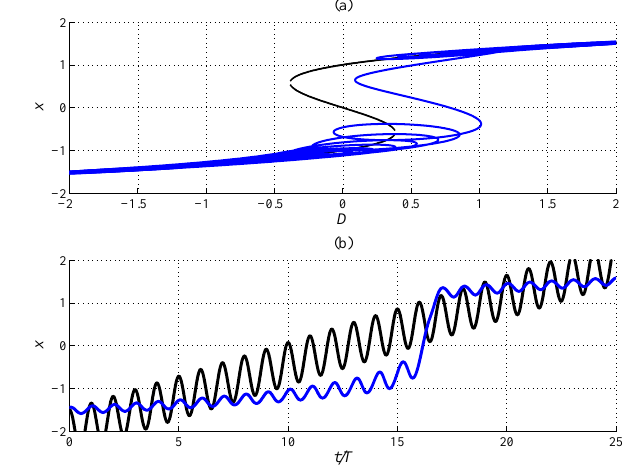
Figure 3. The early warning indicators, response amplification (up- φ lag = per panel), A = D a τ √ , and phase lag (middle panel), 2 π 1 + ω 2 τ 2 1 arctan( ωτ ) calculated for the time series in Fig. 2. We have plot- 2 π ted these indicators prior to the bifurcation at t/T ≈ 15. The 2nd (blue) and 3rd (red) harmonic amplitudes A n /A 1 are also plotted in the lower panel using a sliding window of 5 complete cycles. All indicators are increasing as